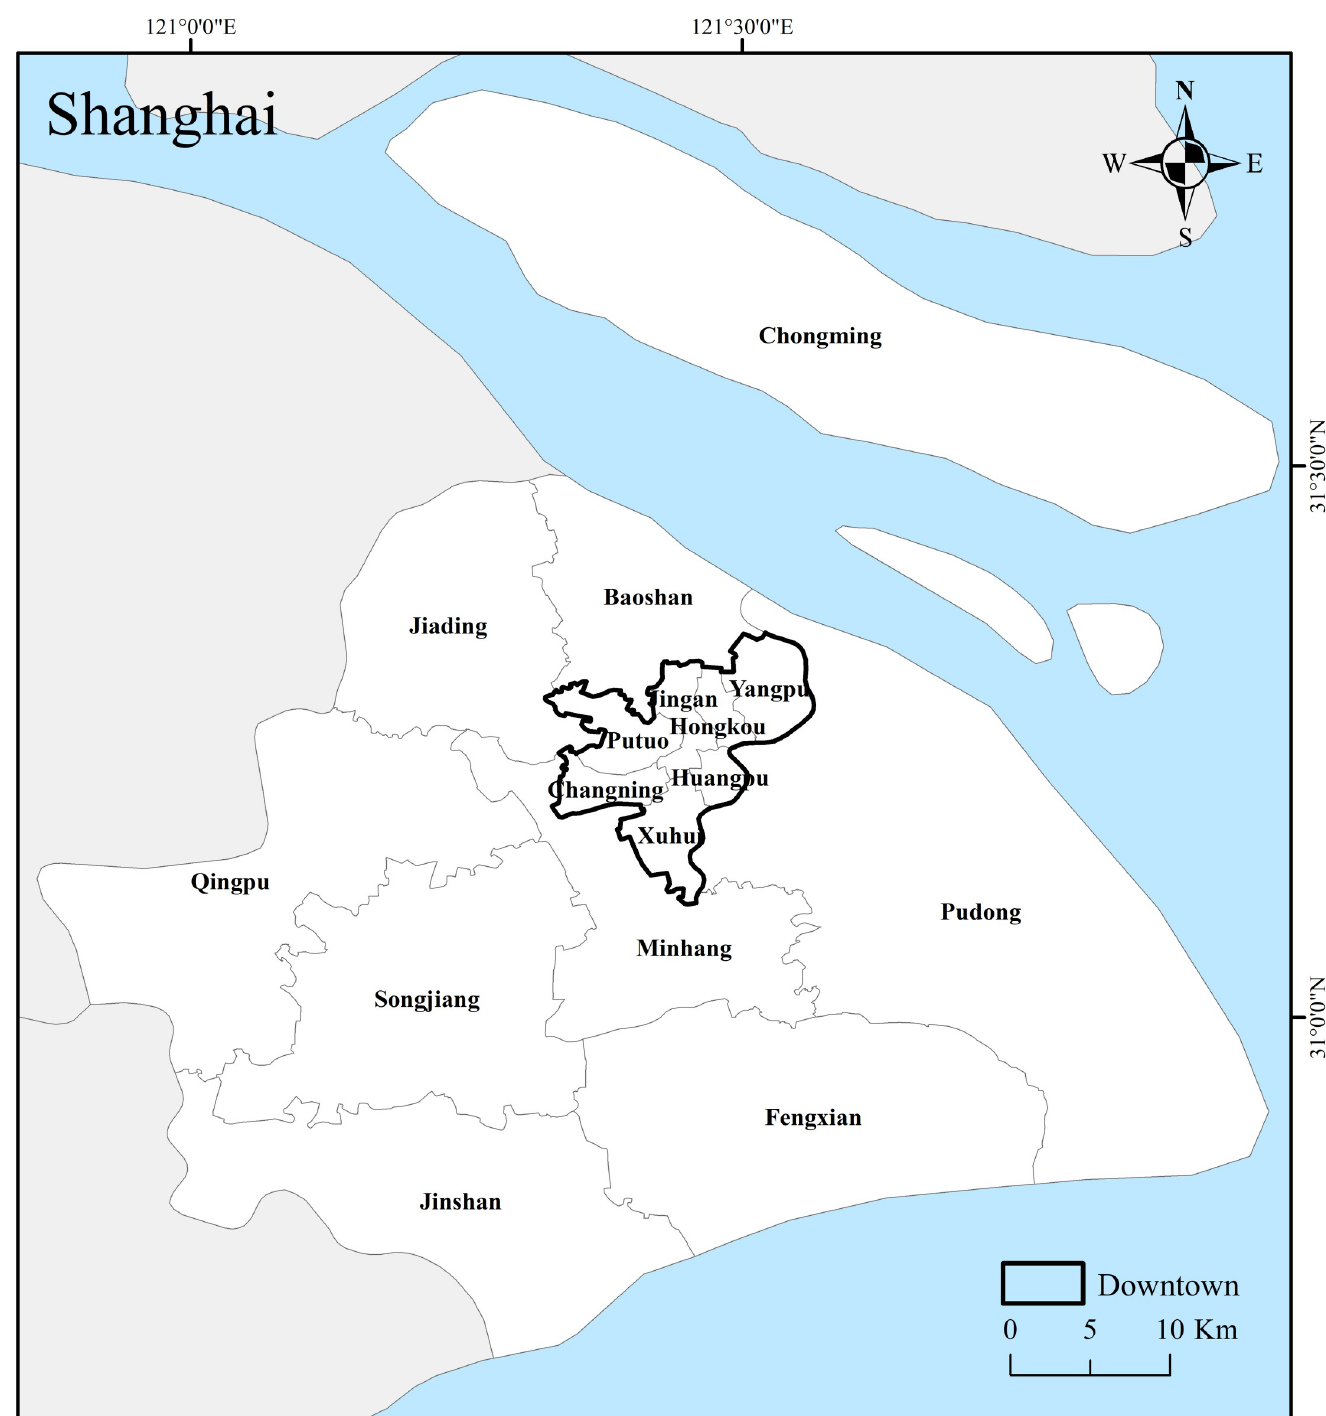
Fig 1. Study area. An overview of Shanghai. (Image Source: https://www.naturalearthdata.com/downloads/10m-cultural-vectors/).